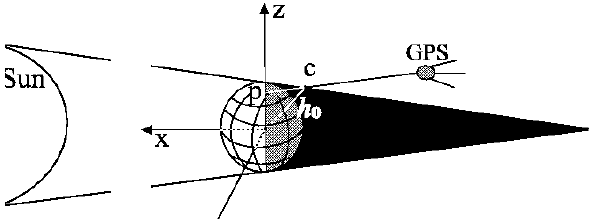
Fig. 1. Scheme for the determination of the shadow altitude h 0 over the ground in the GSE system. GPS – GPS navigation satellite; P – GPS station on the ground; C – intersection point of the transmitter – receiver LOS and the shadow